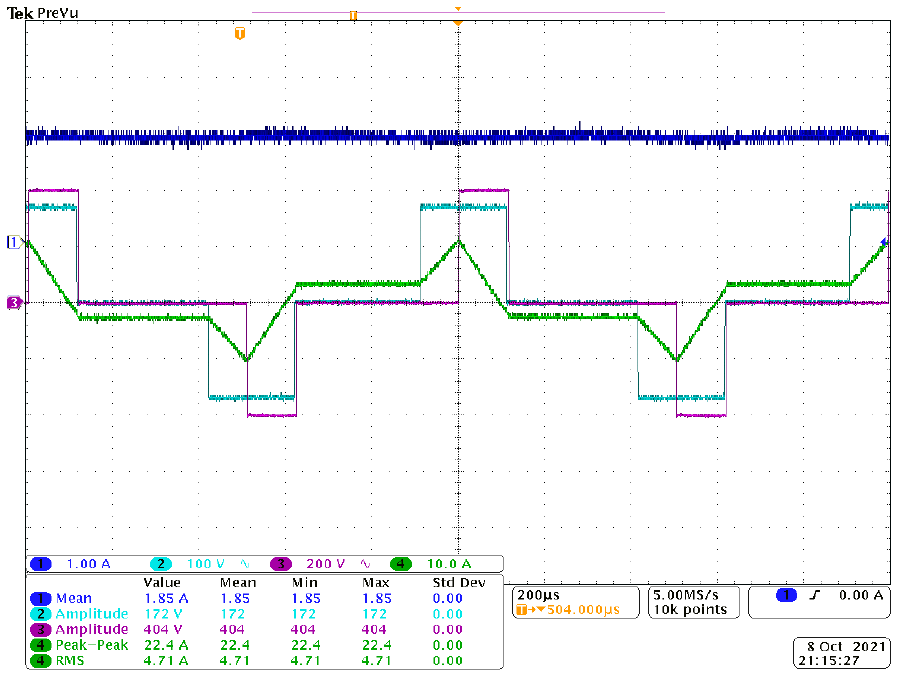
Figure 26. DAB operation at low power under the TPS-based PLM. Table 2. Performance comparison of the PLM method for rated 1 pu, medium 0.5 pu, and low 0.25 pu power for peak and RMS currents.